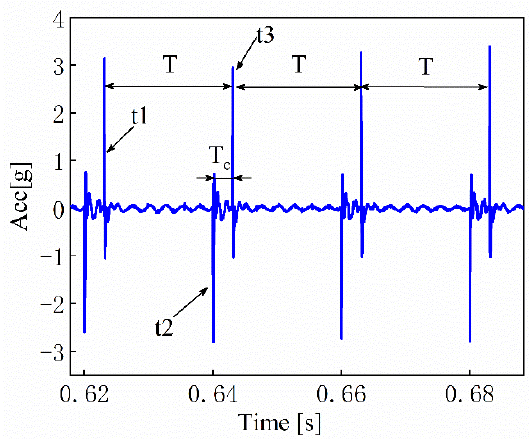
Figure 13. Residual vibration acceleration under cracked state over time.